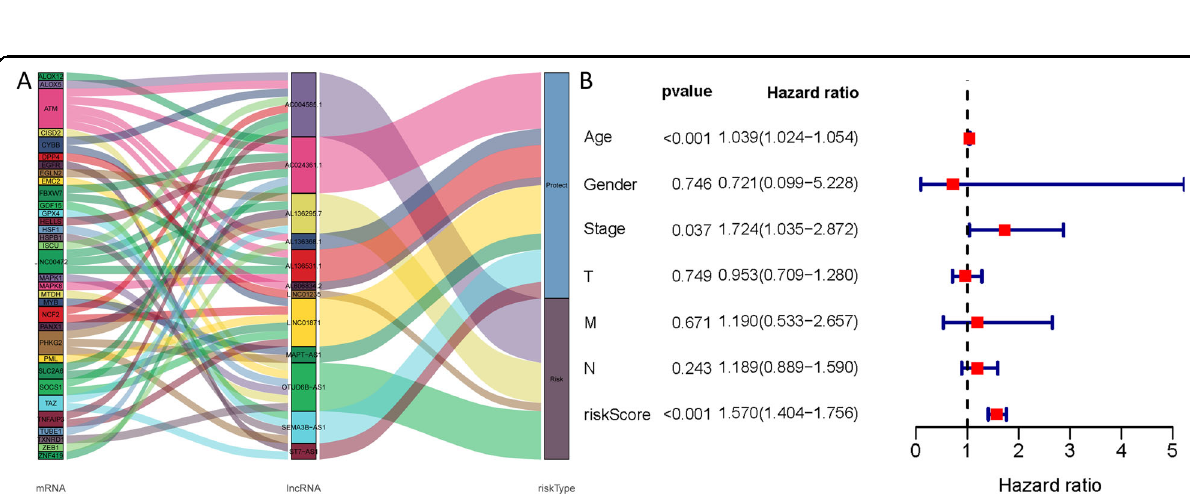
Fig. 7 The analysis between the ferroptosis-related genes and lncRNAs based on BC-TCGA. A Sankey plots shown the relationship between ferroptosis-related genes and ferroptosis-related lncRNAs; B The multivariate COX analysis results based on ferroptosis-related lncRNAs and the result indicated that the lncRNAs signature could as independent prognostic factors for overall survival (HR: 1.570; 95% CI: 1.404 – 1.756). Red means the value of hazard ratio in multivariate analysis. (T: Tumor, N: Lymph Node, and M: